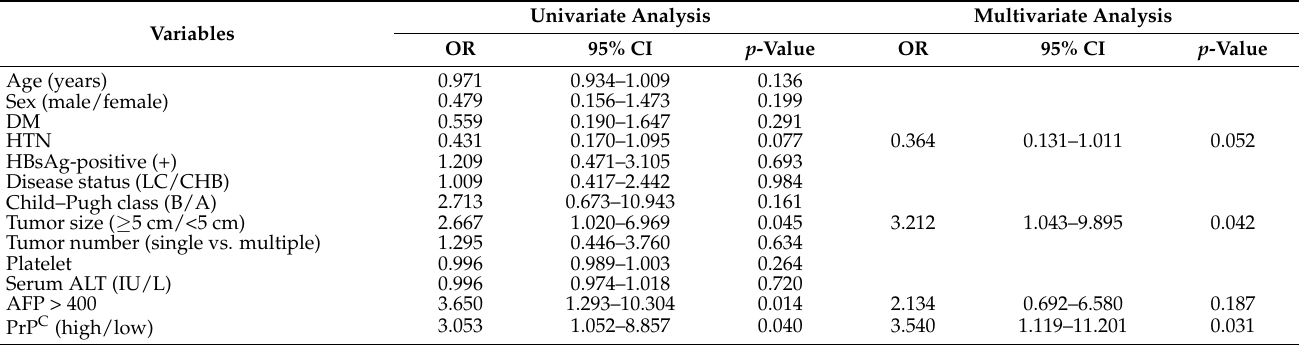
Figure 4. The cumulative recurrence rates in HCC patients with high PrP C were higher than those of patients with low PrP C . The patients with high PrP C showed cumulative survival rates of 23.9%, 36.6%, and 42.3% at 1, 3, and 5 years, respectively. However, the proportion of patients with low PrP C were 20.5%, 23.1%, and 46.2%, respectively ( p = 0.340). Table 3. Univariate and multivariate logistic analysis for 1-year recurrence following surgical resection.